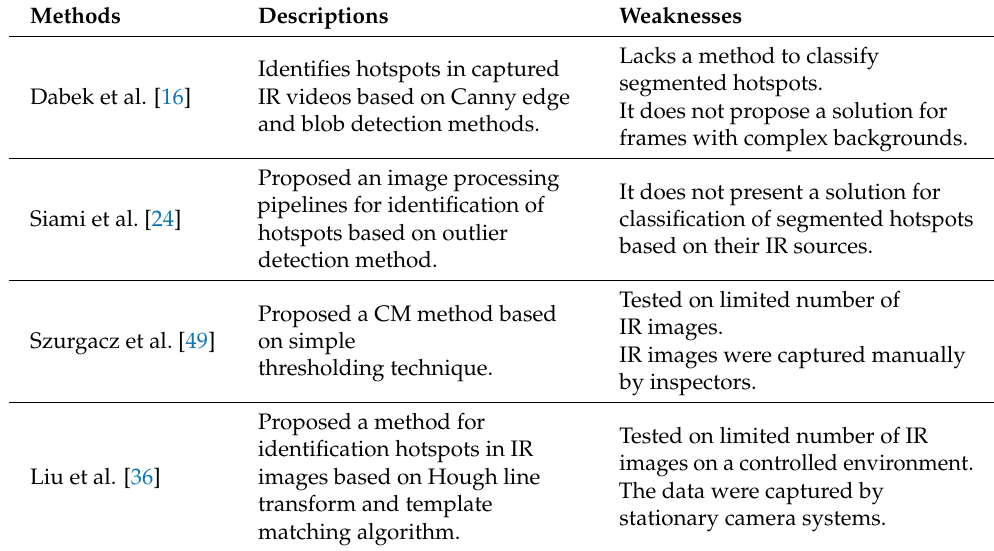
Table 1. Comparison between research that proposed different IRT methods for identifying over- heated idlers in conveyor systems.